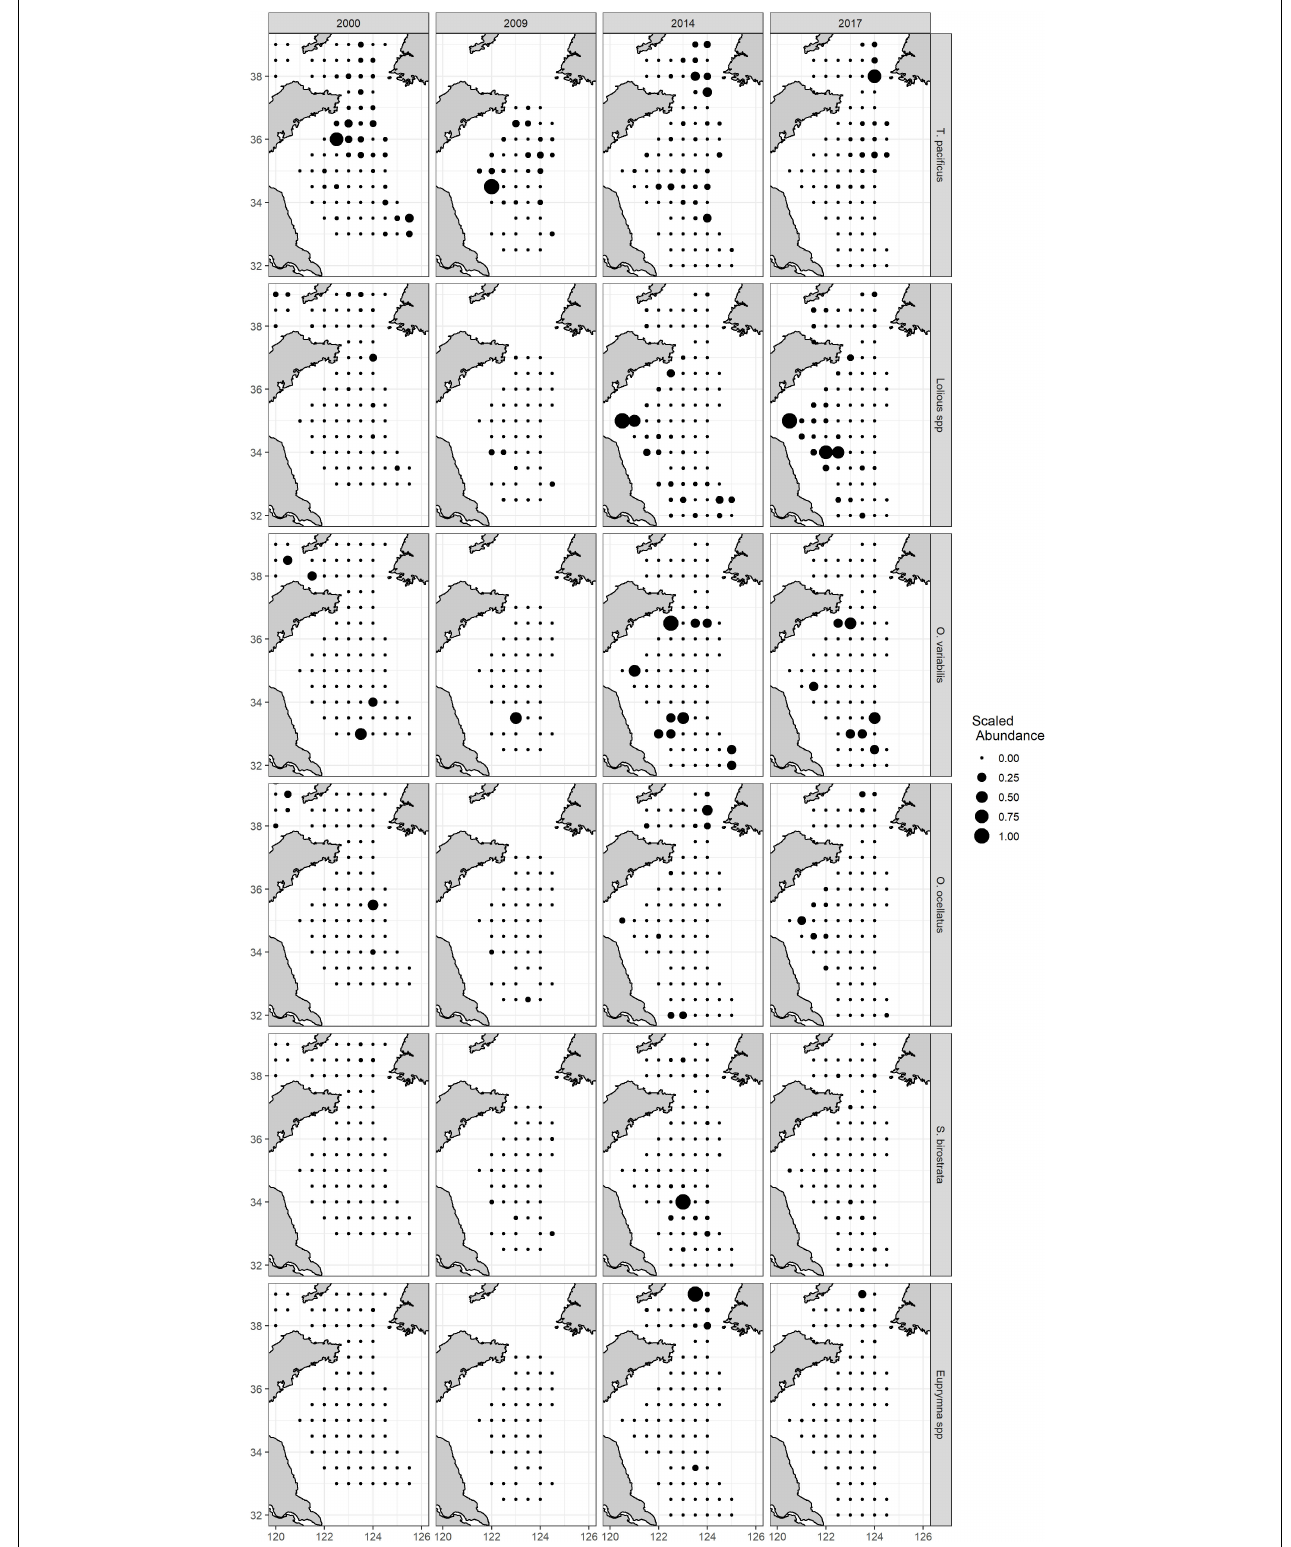
FIGURE 10 | Scaled spatial distribution of abundance index (AI) of different species per year (2000–2017).